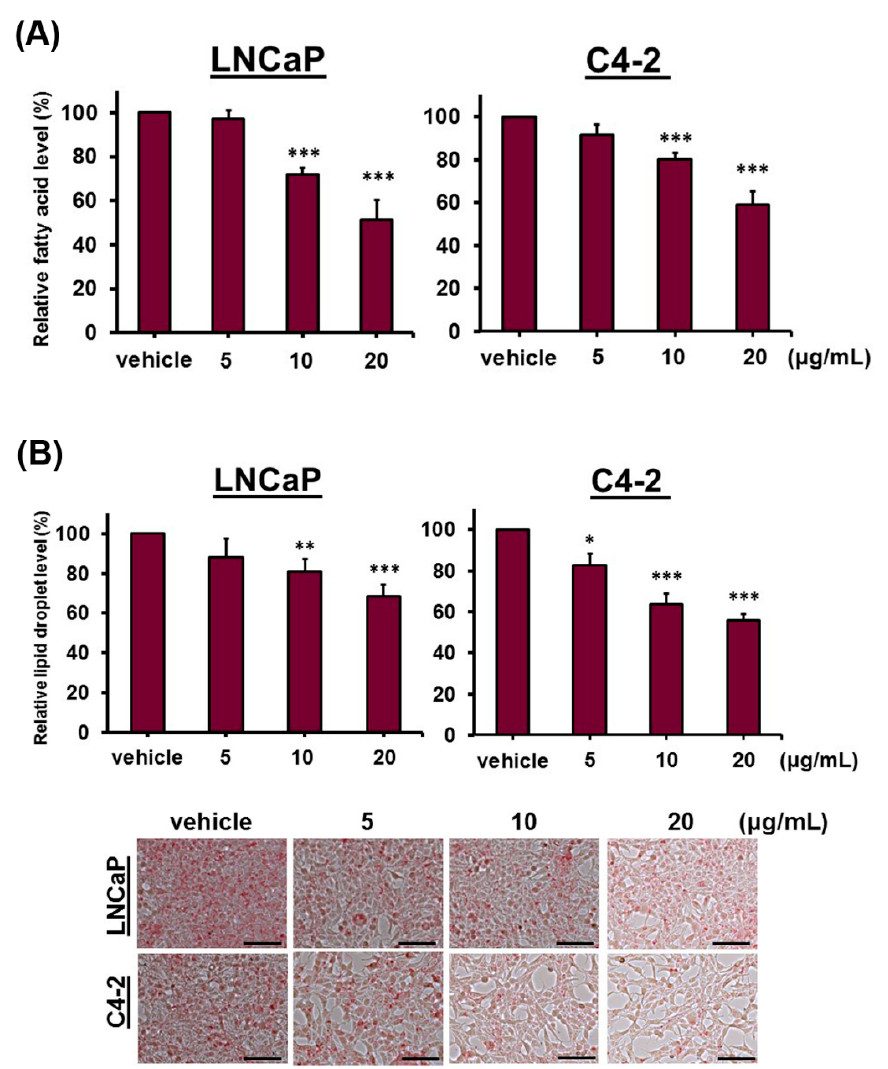
Figure 4. DFE attenuates lipogenesis in PCa cells. ( A ) DFE significantly decreased the intracellular fatty acid levels in LNCaP and C4-2 cells assayed by a Fatty Acid Quantification Kit. Data were shown as the mean ± SD of two independent assays, and normalized to PCa cell numbers. * p < 0.05, ** p < 0.01, *** p < 0.001. ( B ) DFE reduced lipid droplet accumulations in PCa cells examined by an Oil Red O staining assay. Data were shown as the mean ± SD of triplicate analyses in two independent experiments, and normalized to PCa cell numbers. * p < 0.05, ** p < 0.01, *** p < 0.001 (top panel). The lipid droplet accumulation images in PCa cells were shown (bottom panel). Scale bars = 100 µ